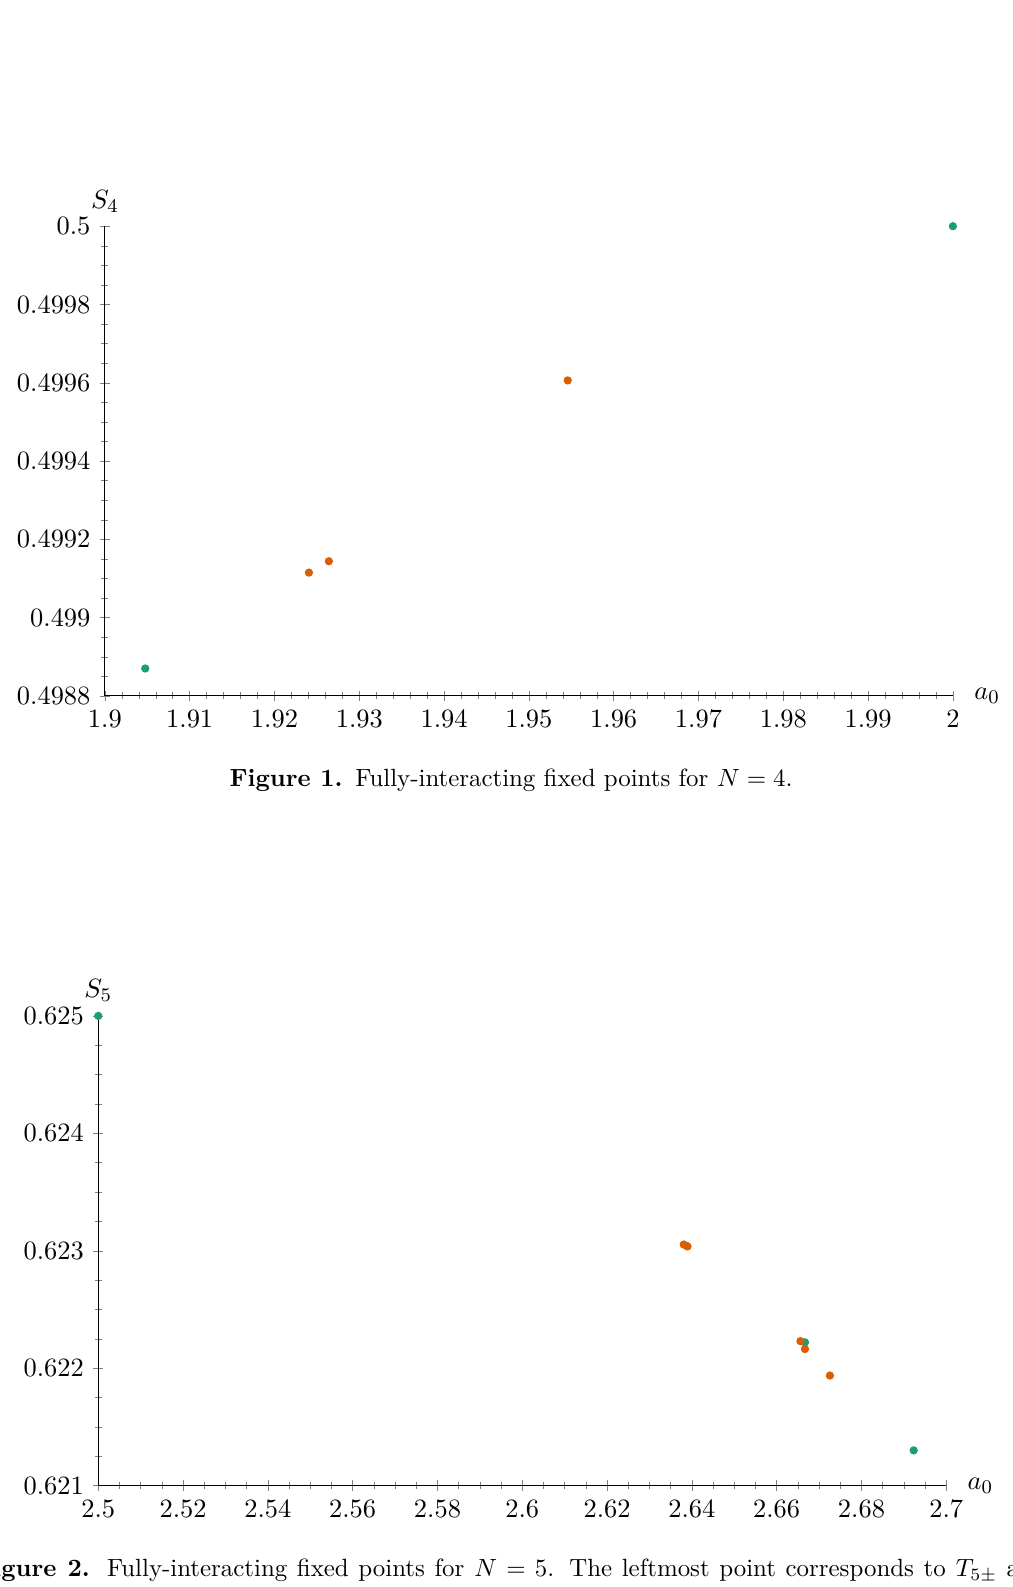
Figure 2. Fully-interacting fixed points for N = 5 . The leftmost point corresponds to T 5 ± and the rightmost to O(5)